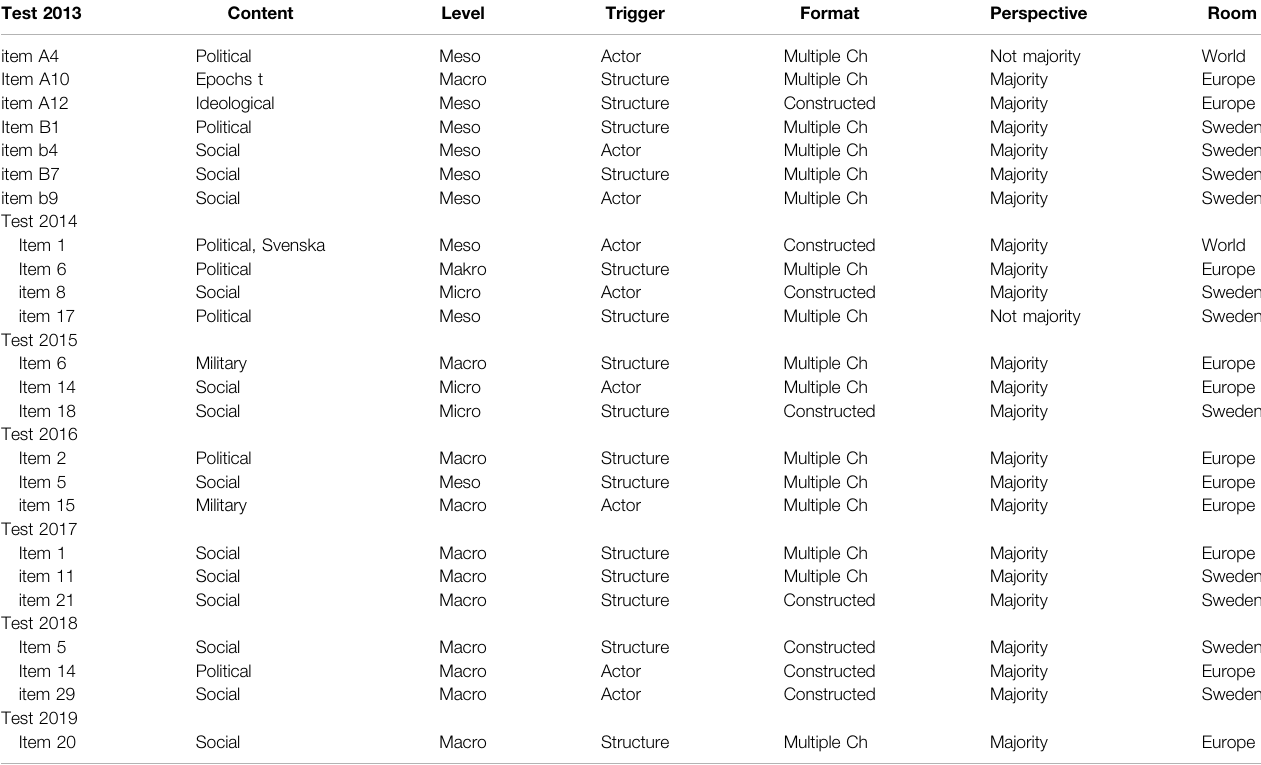
TABLE 4 | Tests and items with a DIF that favors the students taking the course Swedish. Test